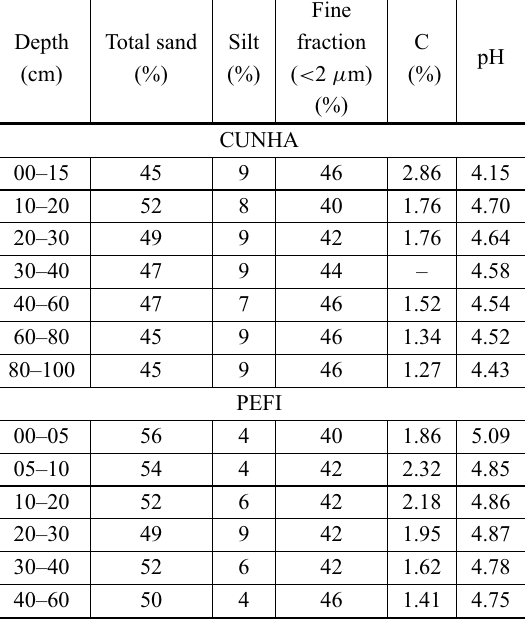
Physico-chemical characteristics of Cunha and PEFI soil